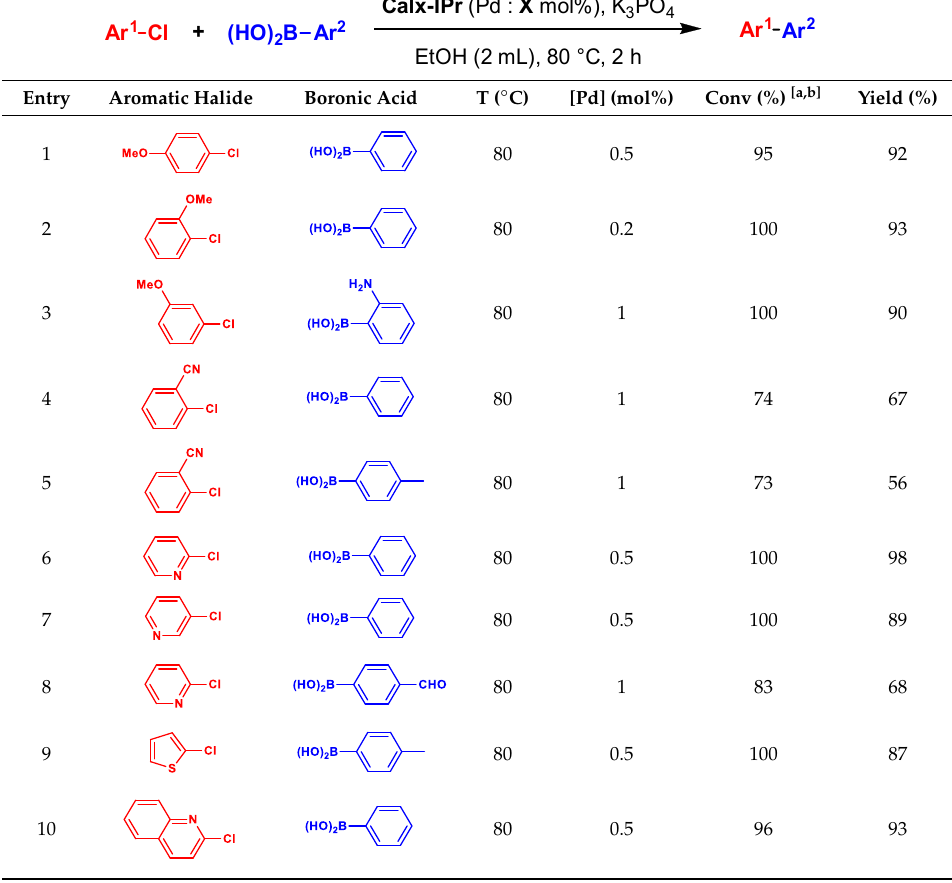
Table 5. ICP-MS analysis of two Suzuki–Miyaura coupling products. Aromatic Halide